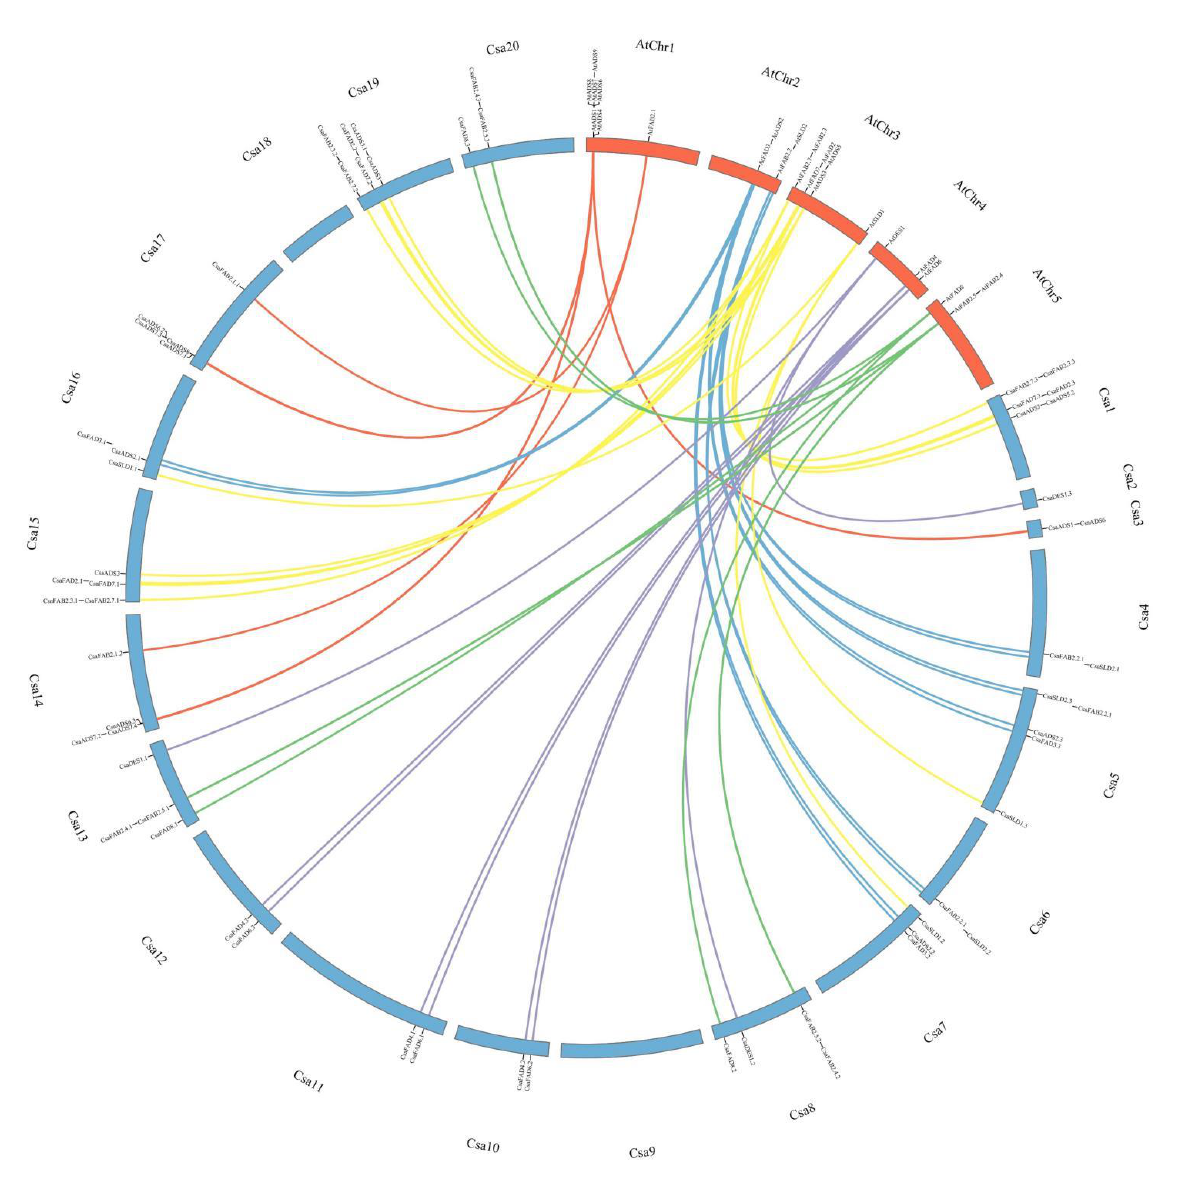
(Table 1). The synteny of fatty acid desaturase genes in A. thaliana and C. sativa is illustrated in Figure 1. The copy number of fatty acid desaturase genes in C. sativa was higher in comparison to that of A. thaliana . Fatty acid desaturase genes were present in 18 among the 20 chromosomes of C. sativa (excluding chromosomes 9 and 18). The size of the proteins was larger in C. sativa , which might explain the difference in amino acid sequence identity.